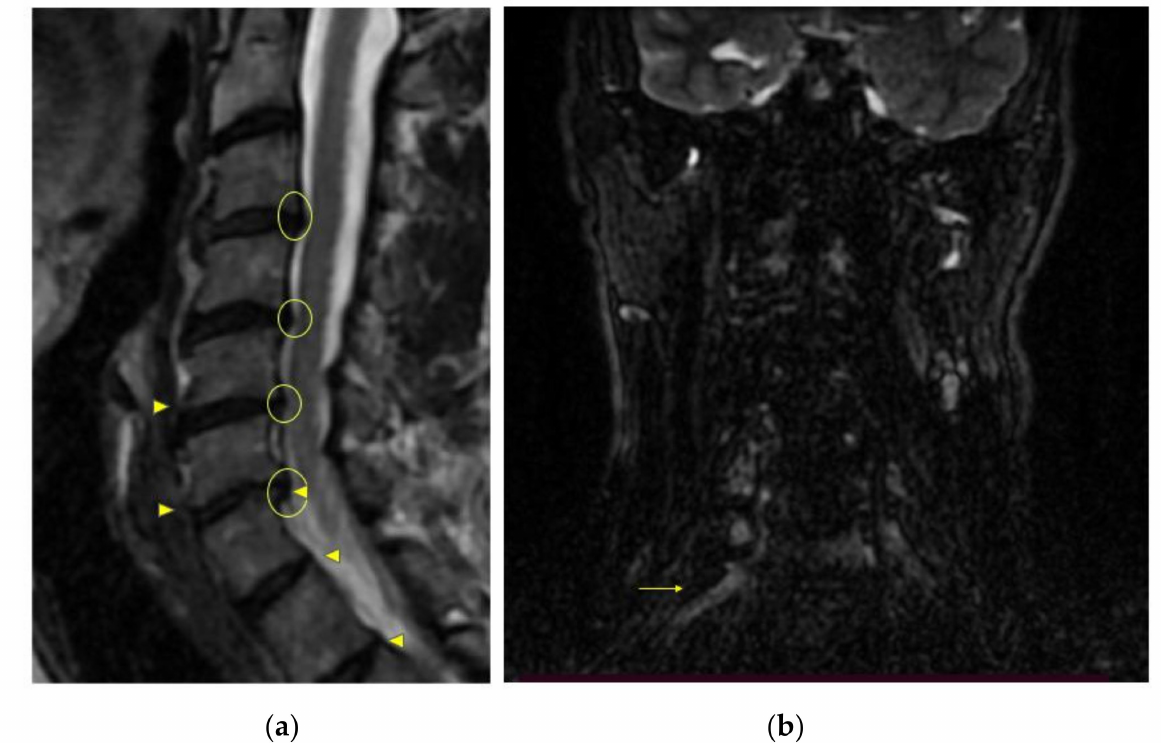
Figure 2. Cervical spine and Brachial Plexus MRI. ( a ) Sagittal T2 weighted image of the cervical spine. Straightening of the lordosis with spondylodiscoartrosic changes in C3-T1 tract are shown. The most evident features are presence of enthesophytes (arrowheads) both anteriorly and posteriorly, where they cause a reduction in intervertebral space height and moderate bulging anulus imprinting CSF column (yellow circles). ( b ) Coronal STIR image of the cervical spine. Right-sided hyperintensity aspect of the inferior trunk and medial cord of brachial plexus (yellow arrow) at C8-T1 level, indicating edema at this level, corresponding to the ulnar nerve